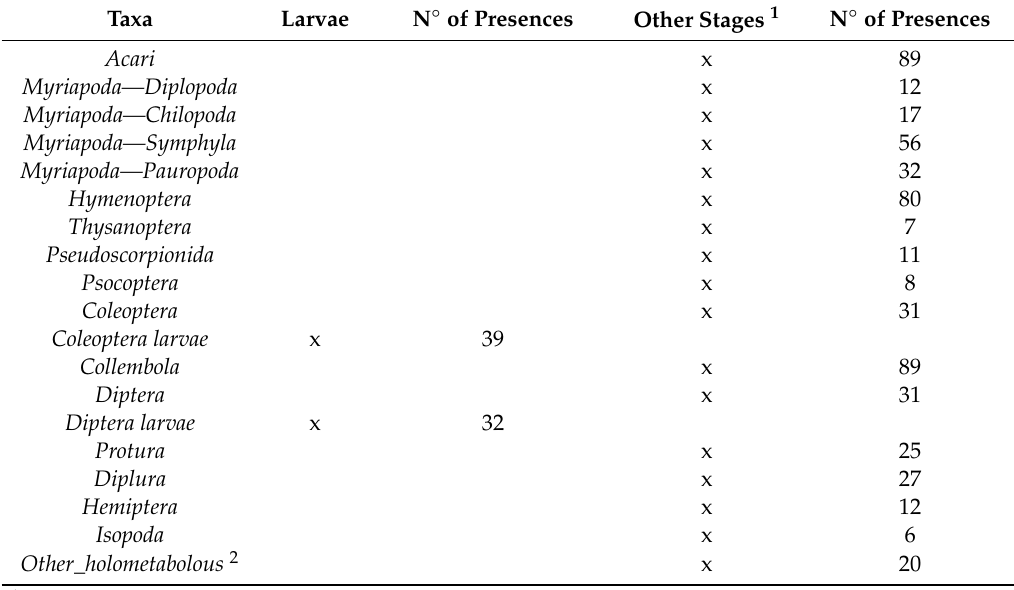
Table 2. Distribution of taxa according to stages considered in the analysis and presence (i.e., number of soil samples in which the taxon has been